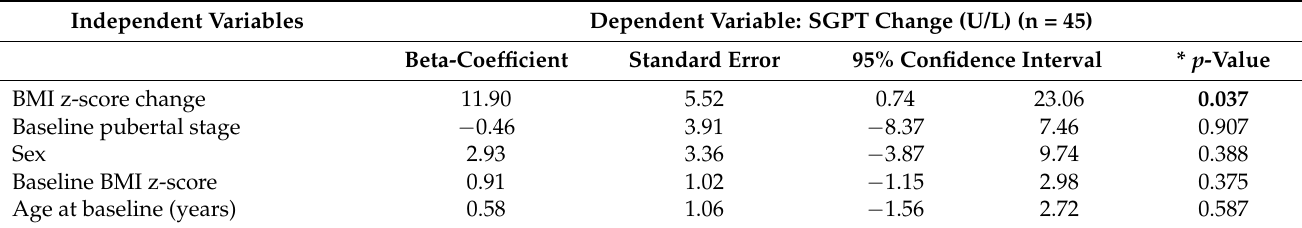
Table 6. Multivariate regression analysis results between BMI z-score change and SGPT change.